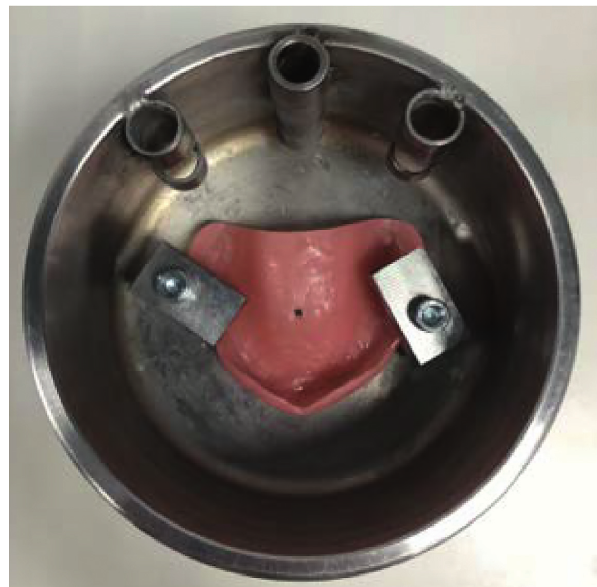
Figure 8: Prosthesis base placed to test the impact resistance. A point was marked at the center of the palate.